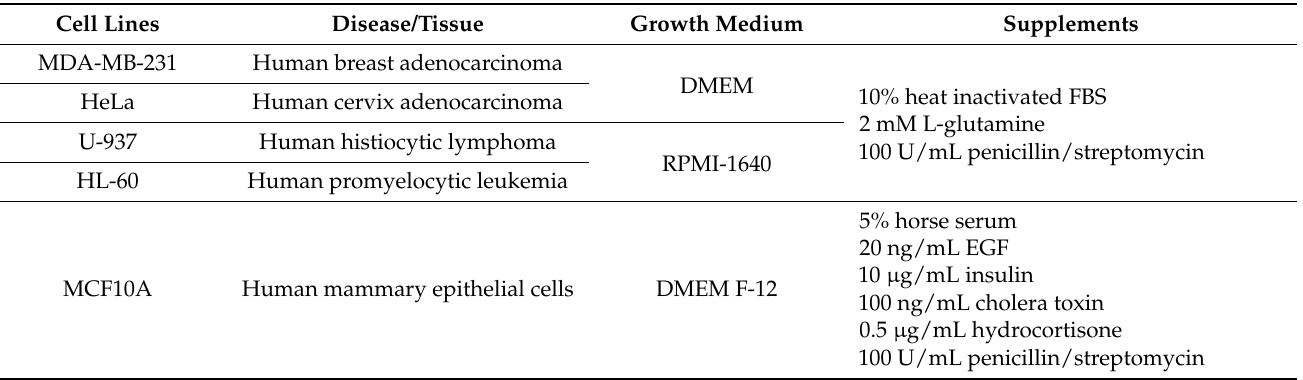
Table 1. List of cell lines, cell culture media, and supplements. Cell